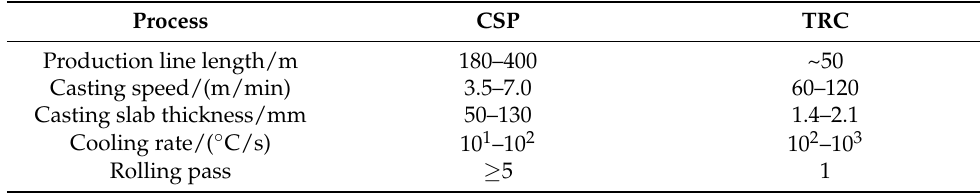
Figure 1. ( a ) Schematic diagrams showing the procedures of the TRC and CSP processes, respectively. ( b ) The thermo-mechanical schedules of the strips produced by the TRC and CSP processes. A 1 is the eutectoid temperature, and A 3 indicates the temperature at which single-phase austenite begins to transform into ferrite forming a mixture of austenite and ferrite during cooling. Table 1. Comparison of technical characteristics of the TRC and CSP processes